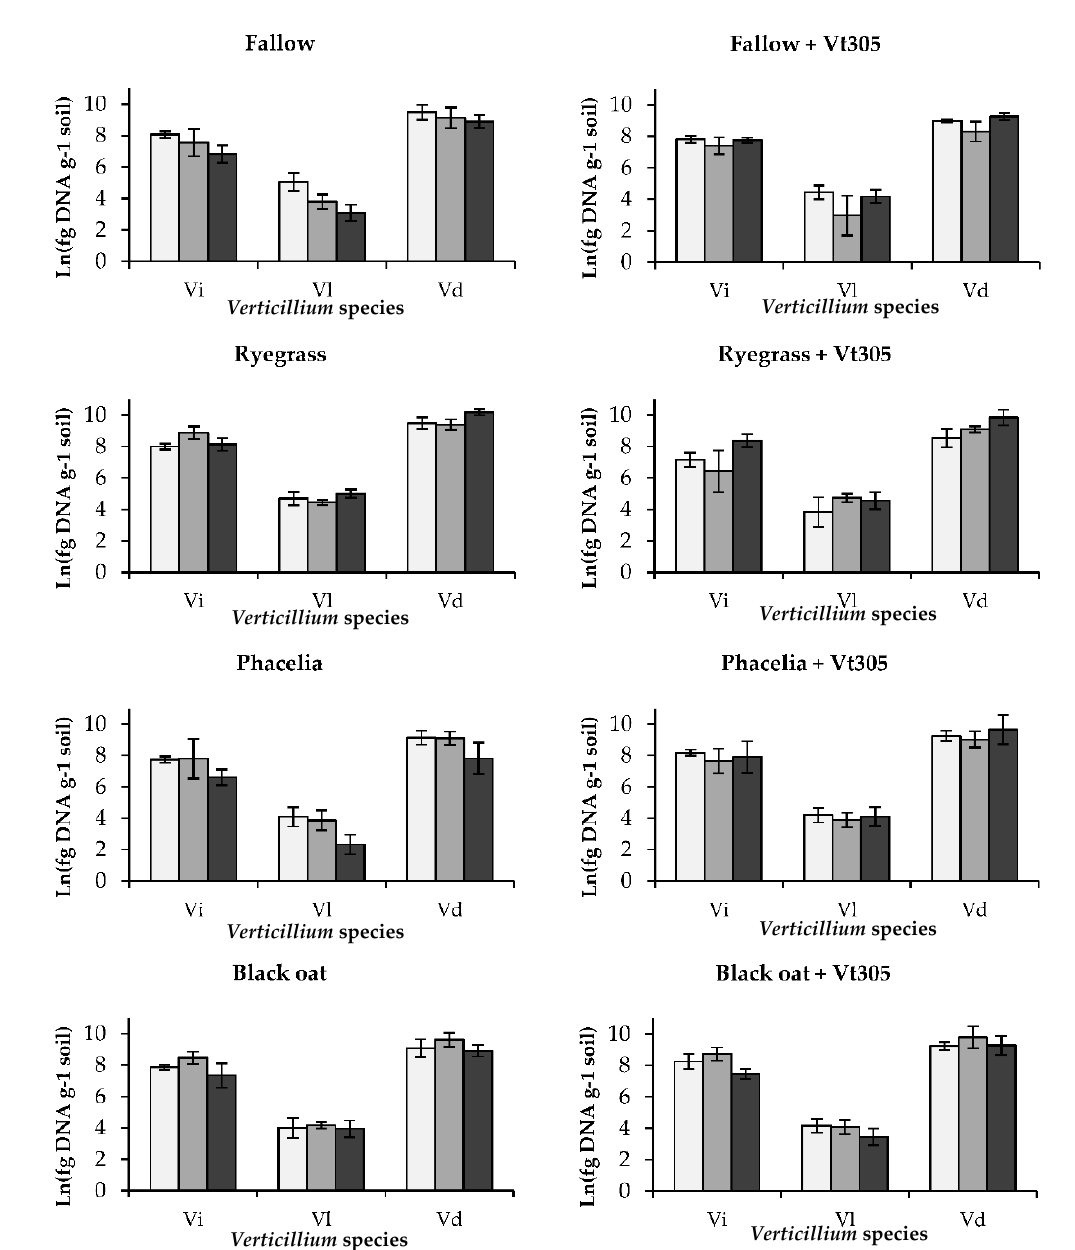
Figure A3. Inoculum densities of V. isaacii (Vi), V. longisporum (Vl) and V. dahliae (Vd) at three time points ( : sowing/planting of crop 1, : incorporation of crop 1 and : harvest of cauliflower) in a grower’s field located in Puurs during the growing season of 2015 in four cover crop systems and two treatment systems of the cauliflower seeds (left panel: no seed treatment; right panel: seed treatment with V. isaacii Vt305 microsclerotia indicated by ‘+Vt305’). Cauliflower seeds were treated with 0.5 mL of tap water (control plants) or 0.5 mL of a microsclerotia (MS) suspension of V. isaacii Vt305 resulting in 500 MS per seed. Values are the mean of 4 replicates and the vertical bars represent the standard error of the mean. Data were ln transformed before statistics. No statistical differences were detected for the different Verticillium species in the different growing systems using Tukey tests ( p < 0.05).